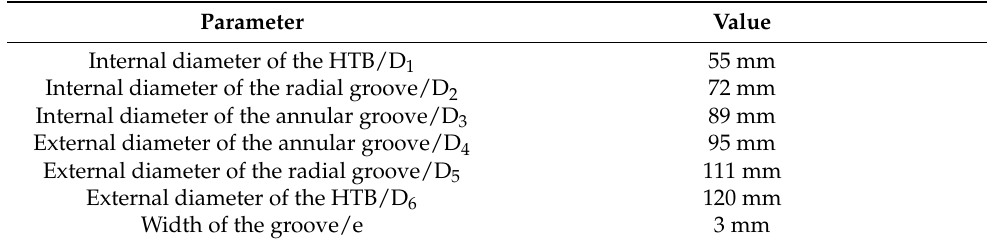
Table 2. Parameters of the HTB for the WSSC prototype.